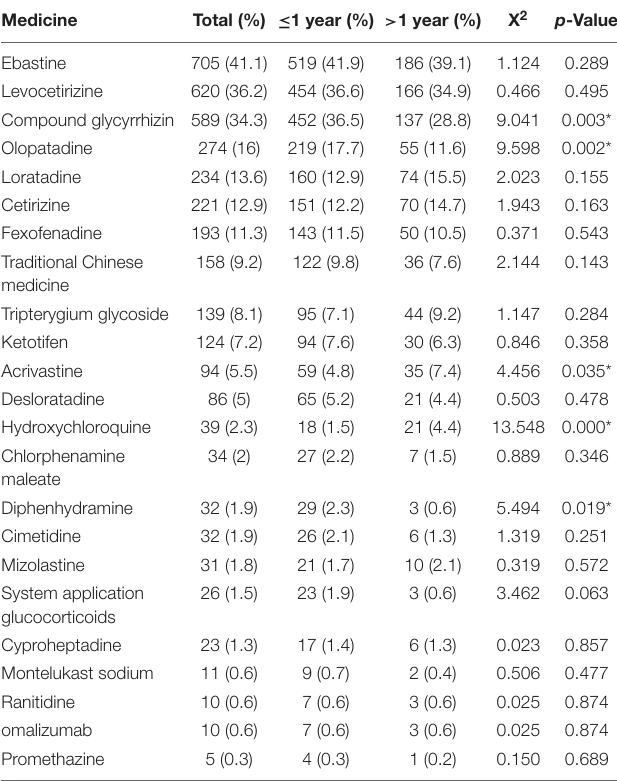
TABLE 3 | Therapeutic options in outpatients with urticaria in different course by clinical reality.